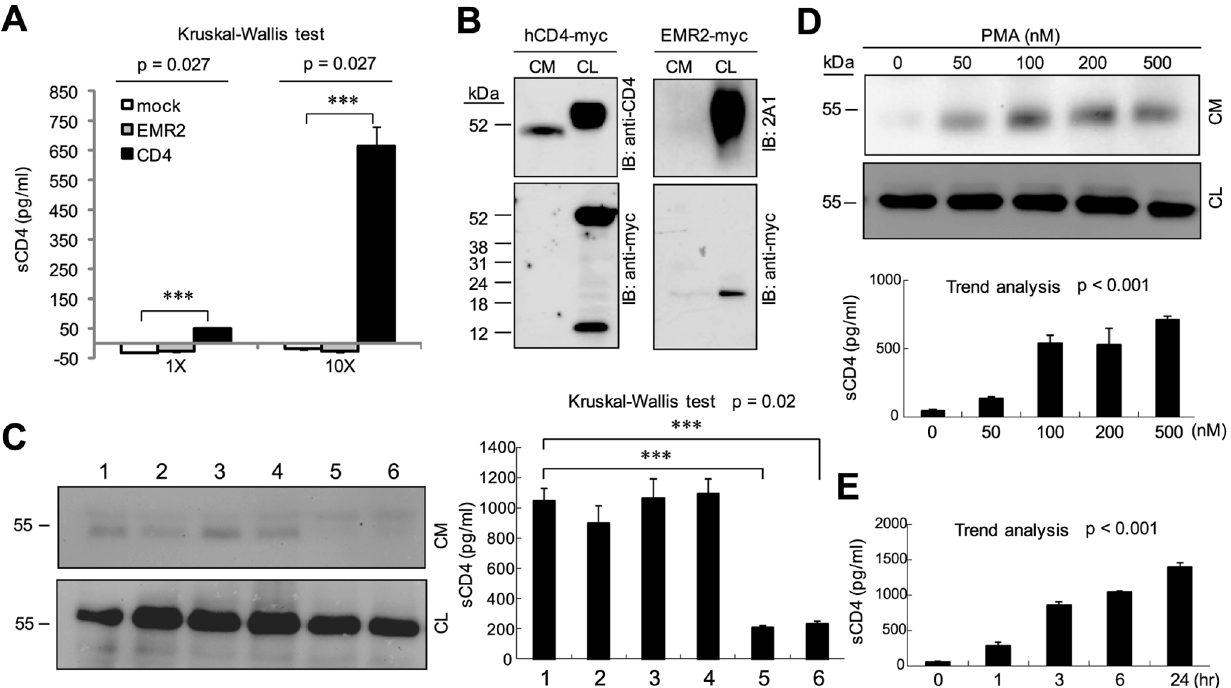
Figure 1. CD4 is shed by MMP-like proteinases in transfected CHO-K1 cells. (A, B) CHO-K1 cells were transiently transfected with the hCD4- myc or negative control EMR2-myc expression construct. Production of sCD4 is evaluated by ELISA (A) and WB (B) analysis. Conditioned medium (CM) and cell lysates (CL) were probed with 2A1 (specific to EMR2), anti-CD4 and anti-myc mAbs in WB analysis. Kruskal-Wallis test across all three groups of 1X and 10X concentration shows p=0.027. Dunn’s multiple comparisons post-test p values between groups show ***P , 0.001. (C) sCD4 production is inhibited by pan-MMP inhibitors, GM6001 and TAPI-0. CHO-K1 cells transiently transfected with the hCD4-myc construct were treated with various protease inhibitors (1, Control; 2, DMSO; 3, Furin protease inhibitor I; 4, Pepstatin A; 5, GM6001; 6, TAPI-0) then analyzed by WB (left panel) and ELISA (right panel). Kruskal-Wallis test across all six groups shows p=0.02. Dunn’s multiple comparisons post-test p values between groups show ***P , 0.001. (D, E) CHO-K1 cells transiently transfected with the hCD4-myc construct were treated with PMA in various concentrations (D) for 1 hr or 50 nM PMA for different time periods (E) then analyzed by ELISA and WB. ELISA. Statistical significance was assessed by the trend